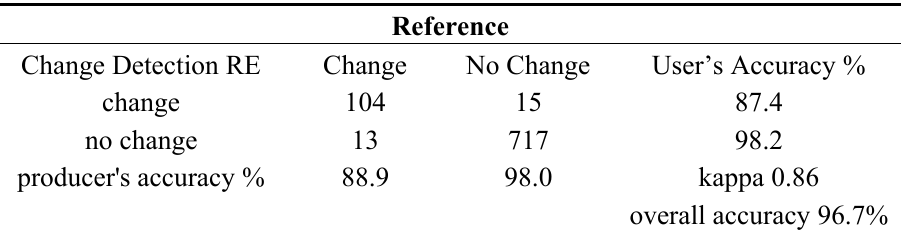
Table 3. Error matrix for the change detection results using RapidEye data.